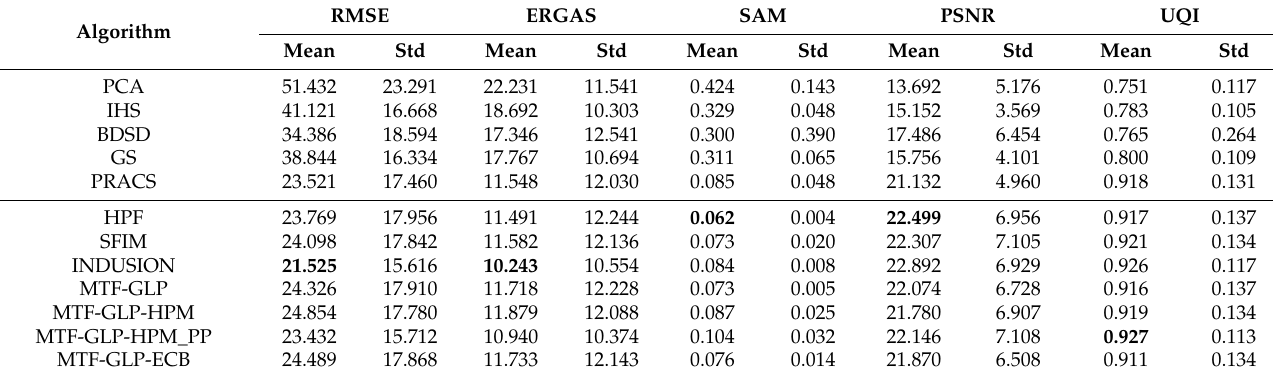
Table 3. Quality indices for the Grayscale Thermal Pansharpened images of the FLIR ADAS dataset for each pansharpening algorithm tested.